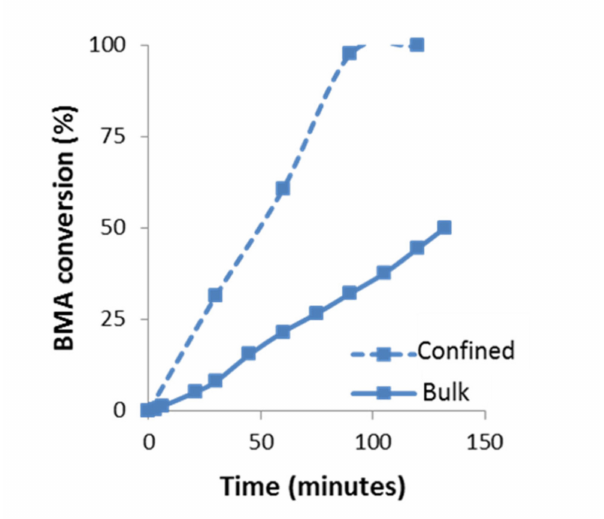
Figure 6. Kinetics of BMA polymerization at 60 ◦ C under bulk and confinement conditions (AAO template of 60 nm), determined by 1 H-NMR spectroscopy, using CDCl 3